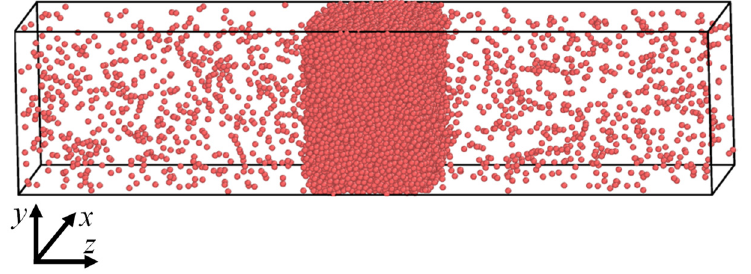
Figure 1. Phase equilibria simulation scheme with denoted interface region boundary positions and mass fluxes through the interfaces. The density profile for the scheme was obtained from the pro- duction run of the liquid-vapor phase equilibria simulation.